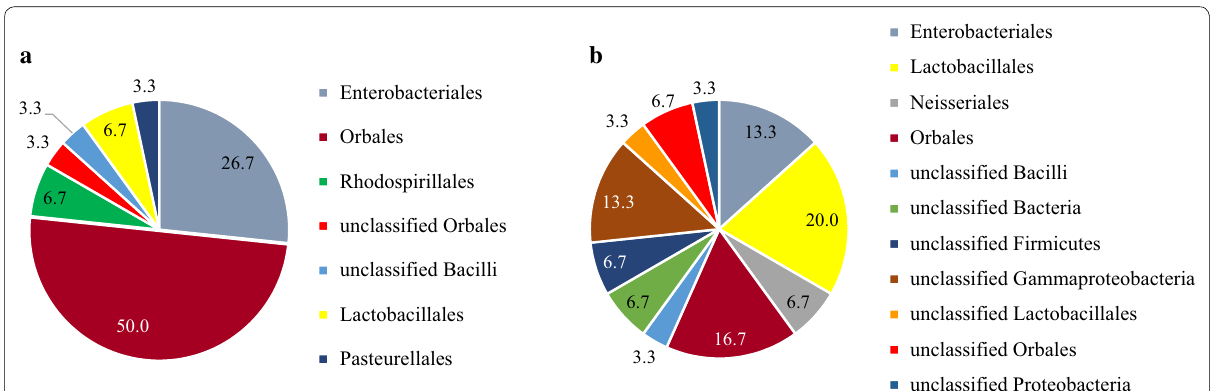
Fig. 1 Compositions of 30 BLAST‑matched sequences of 30 DNA sequences from the unexposed bees ( a ), and 30 BLAST‑matched sequences of 30 DNA sequences from the exposed bees ( b ) at the order